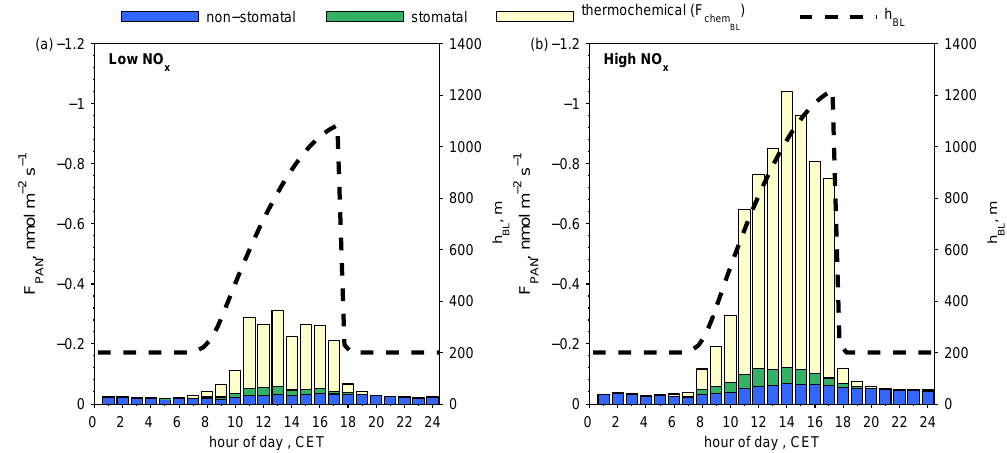
Figure 5. Modelled stomatal and non-stomatal PAN deposition fluxes and PAN loss due to thermochemical decomposition for (a) low and (b) high NO x periods at the Mainz Finthen grassland site. The dashed line marks the theoretical boundary layer height used for the calculation of the PAN decomposition (for details see